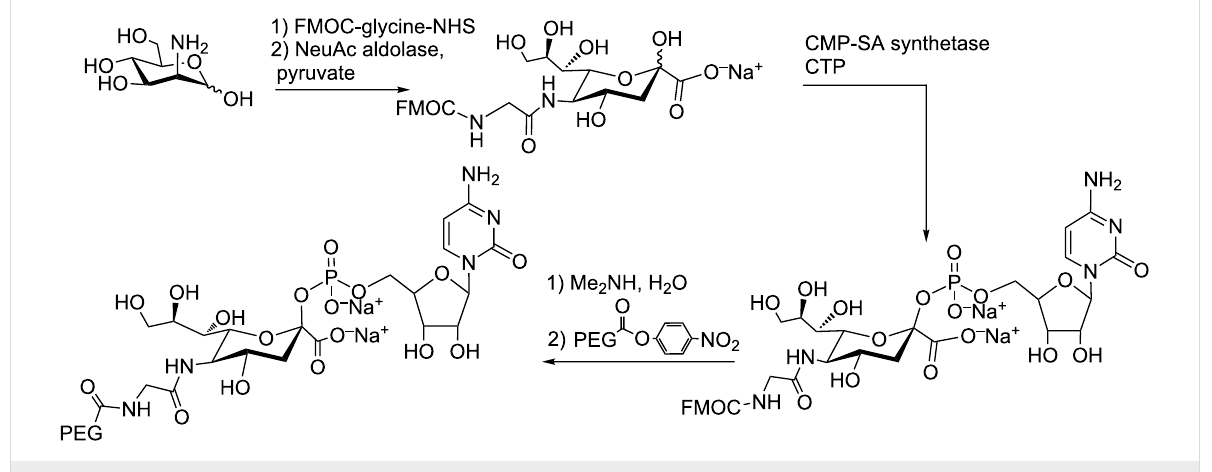
be galactosylated by a galactosyltransferase and both, the monosaccharide and the disaccharide, may be acceptors for PEG-sialic acid (Scheme 2). This technique was applied to